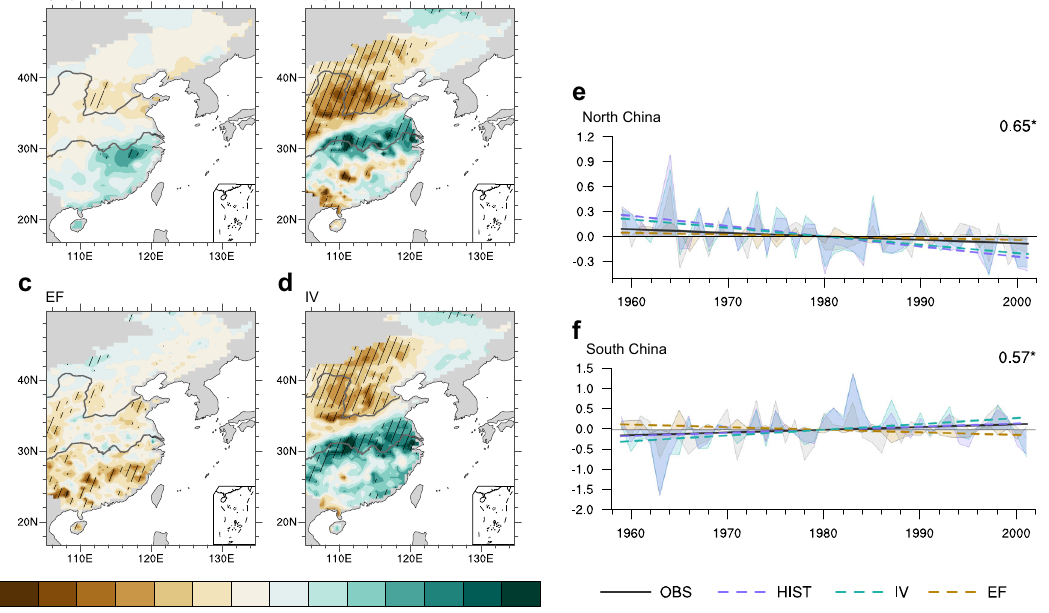
Fig. 1 Linear trends in the annual mean precipitation. Linear trends (mm day − 1 decade − 1 ) in a observational data (CN05.1 and APHRO), b the WRF historical (HIST) run, c the response to external forcing (EF), and d the WRF internal variability (IV) run during the time period 1959 – 2001. The hatched areas and asterisks denote a signi fi cance level of 0.05. The two boxes in a indicating the location of North China (35 – 43°N, 110 – 122°E) and South China (24° – 32°N, 110° – 122°E). The two gray lines on the map show the location of the Yellow River in North China and the Yangtze River in central China. The time series of regional mean precipitation anomalies (shaded areas; mm day − 1 ) and the linear trends (lines; mm day − 1 yr − 1 ) over e North China and f South China. The correlation coef fi cients between HIST and observation are shown in the upper right corner of each